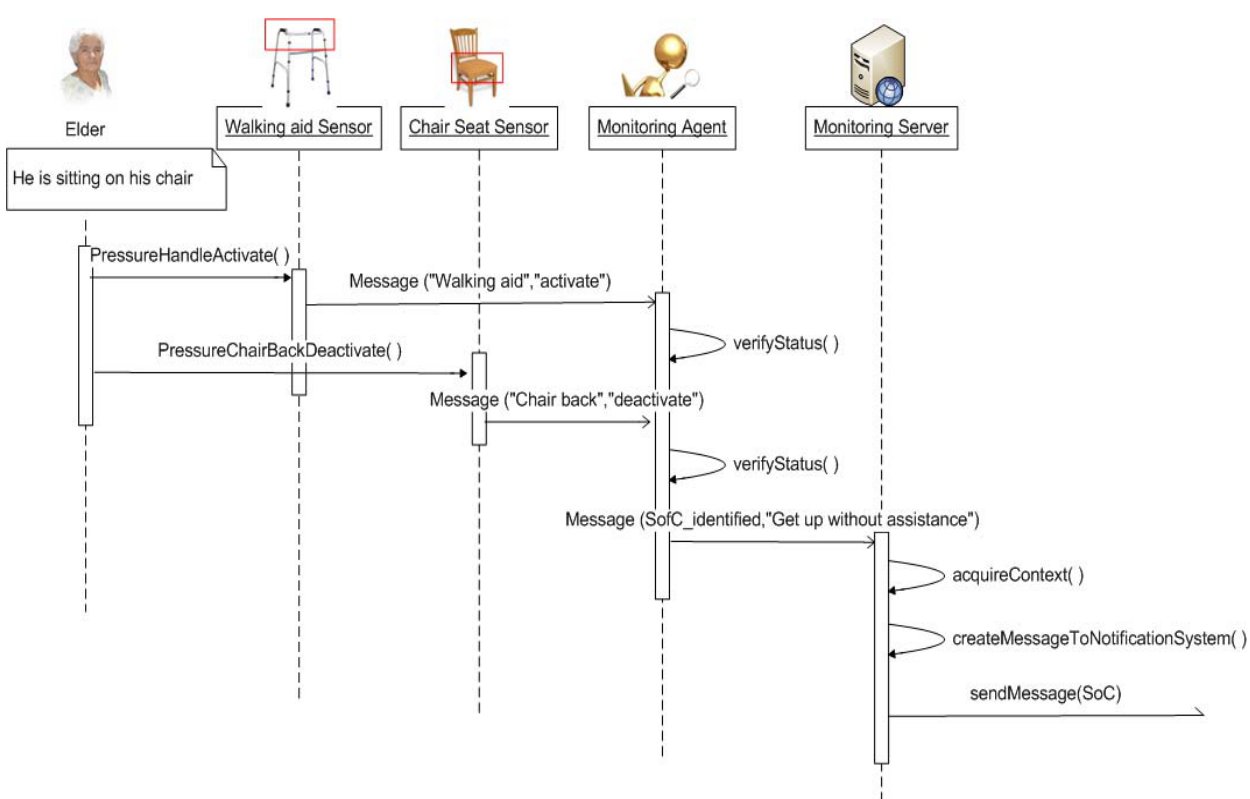
Figure 9. Sequence diagram for the inference of the ‘Get up without assistance’ situation of